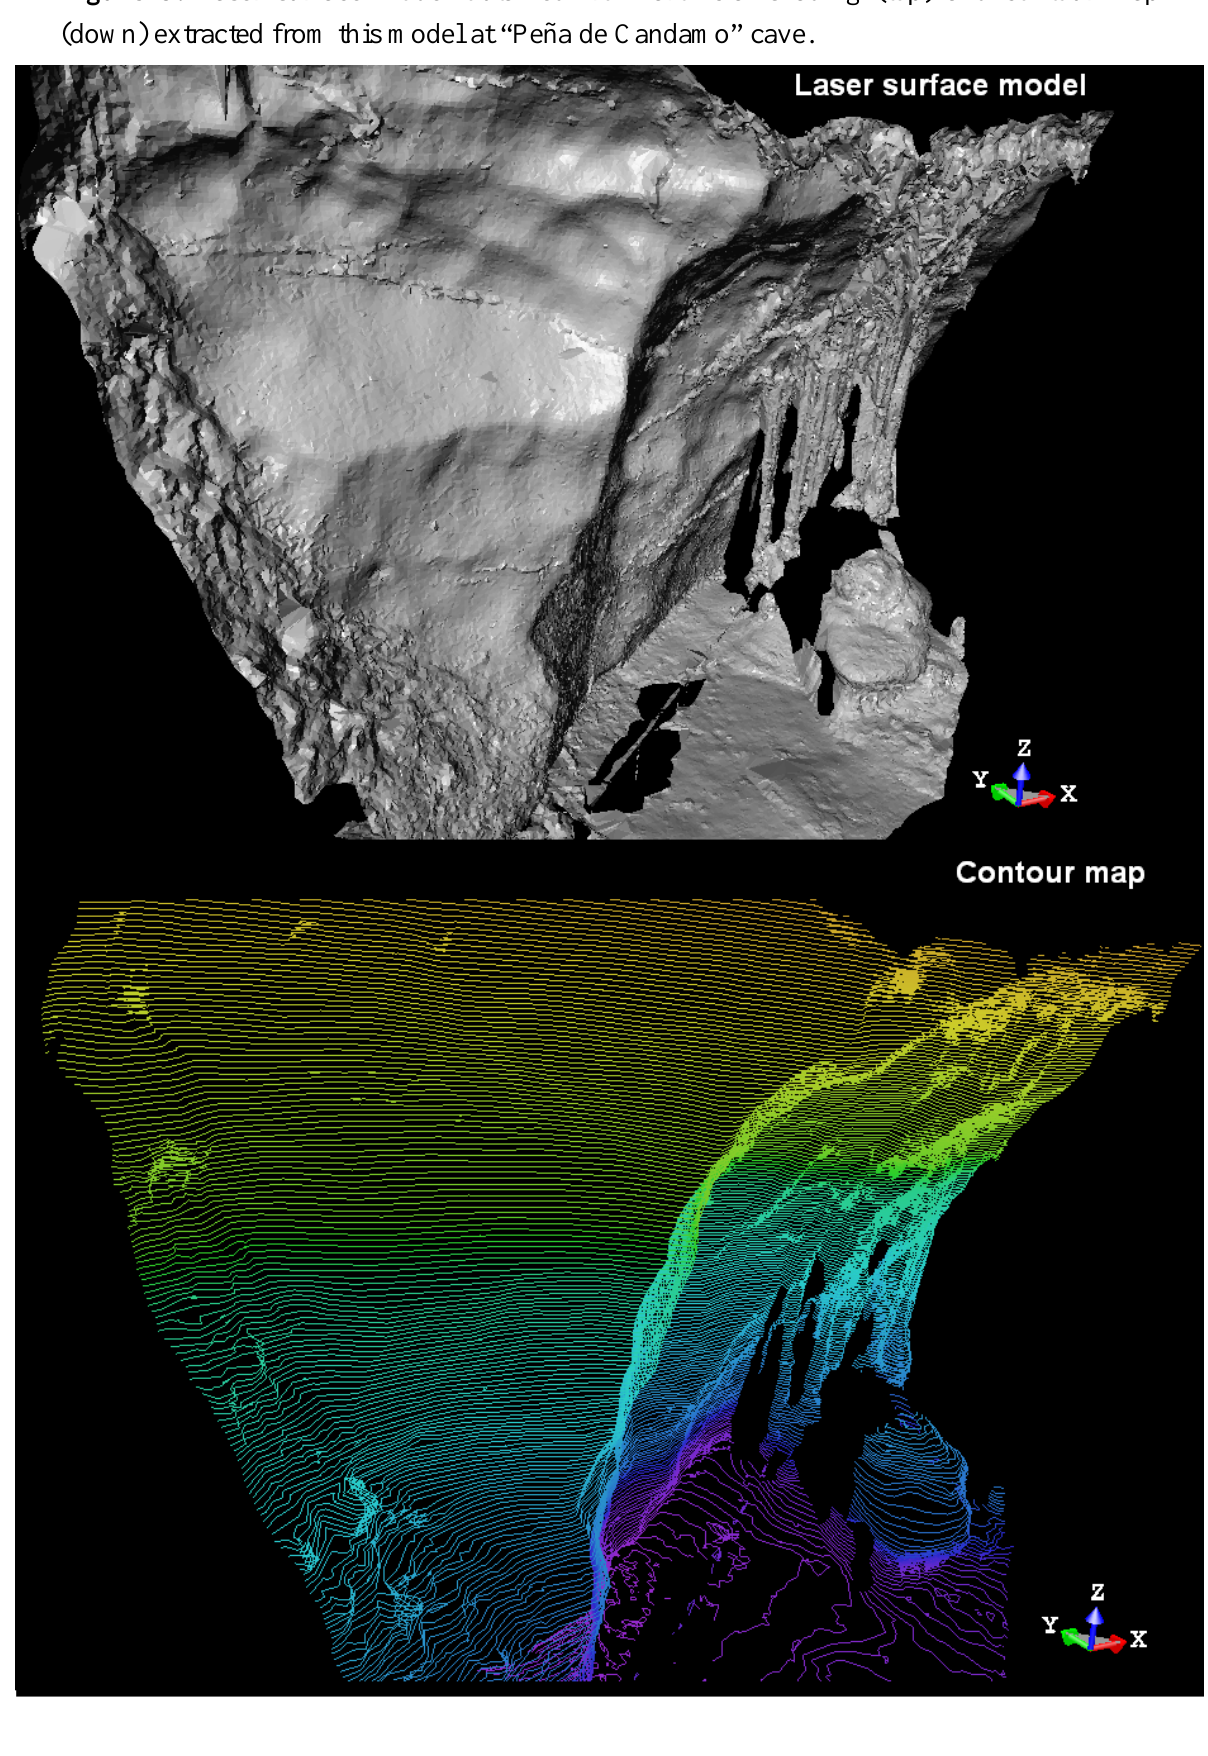
Figure 5. Laser surface model obtained from artificial shading (top) and contour map (down) extracted from this model at “Peña de Candamo”